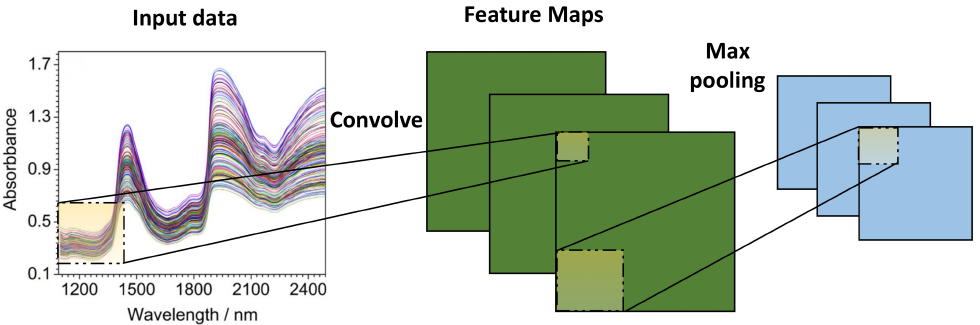
Figure 4. Illustration of a convolutional and pooling layer used in